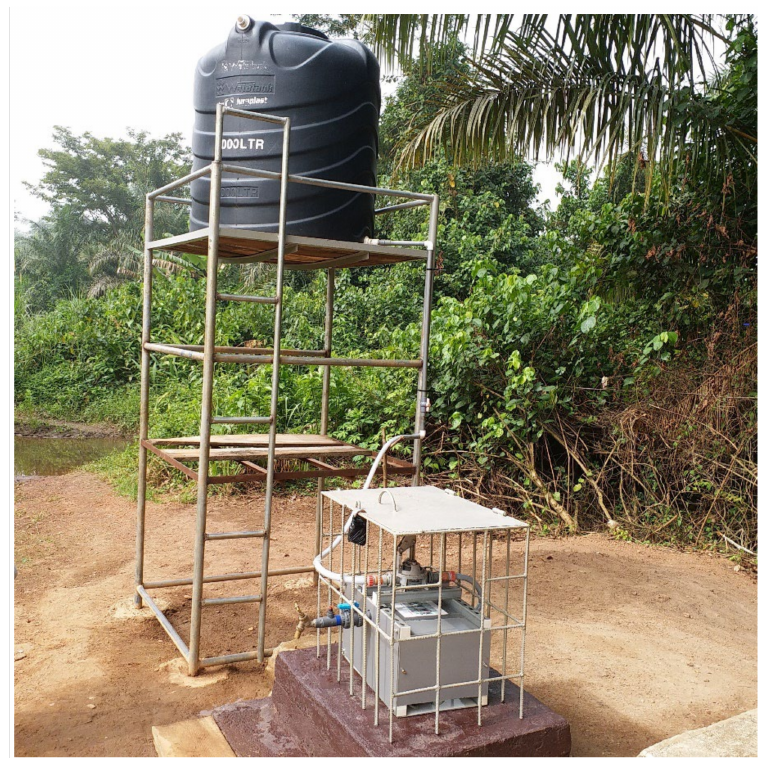
Figure 1. The typical